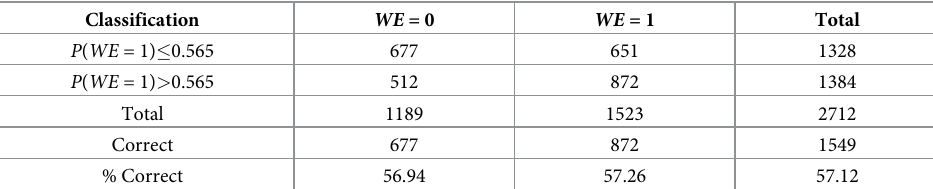
Table 3. Logit model: Predicted-observed classifications.